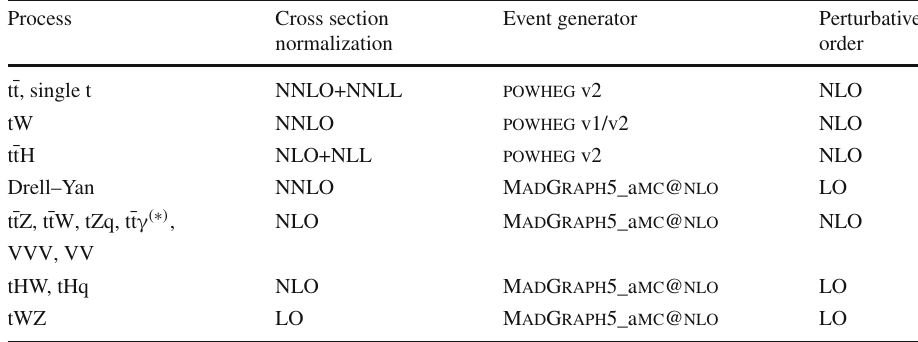
Process Cross section Event generator Perturbative